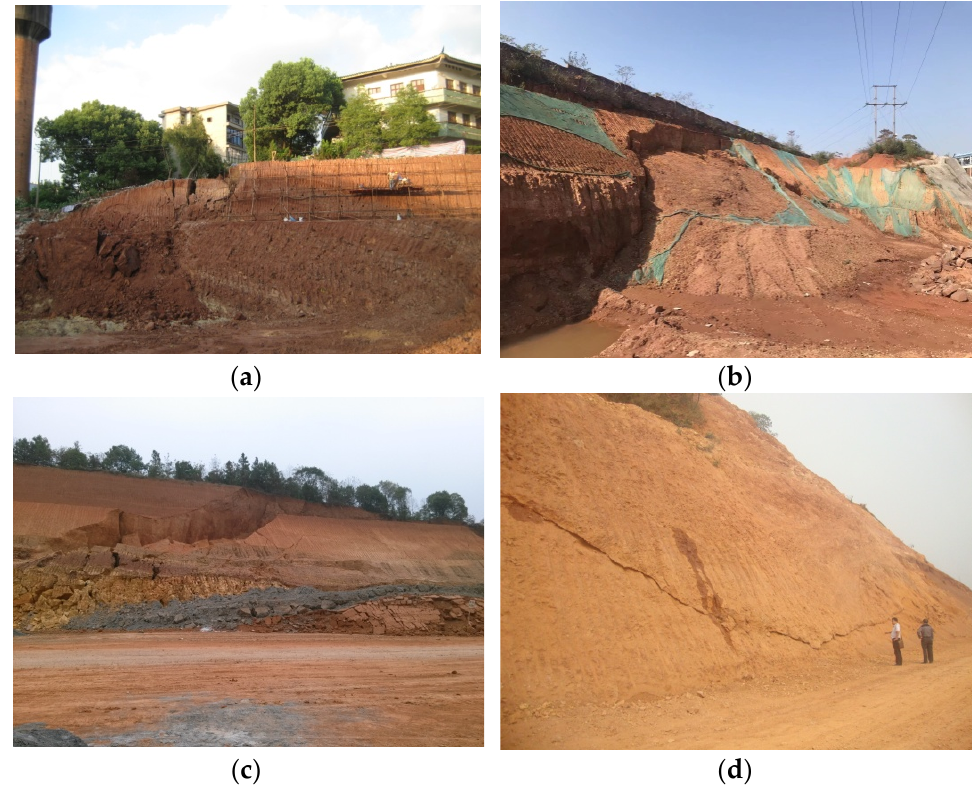
Figure 2. Cases of slope failures after completion of excavations caused by: ( a ) the vibration; ( b ) and ( c ) rain infiltration; ( d ) excavation unloading.